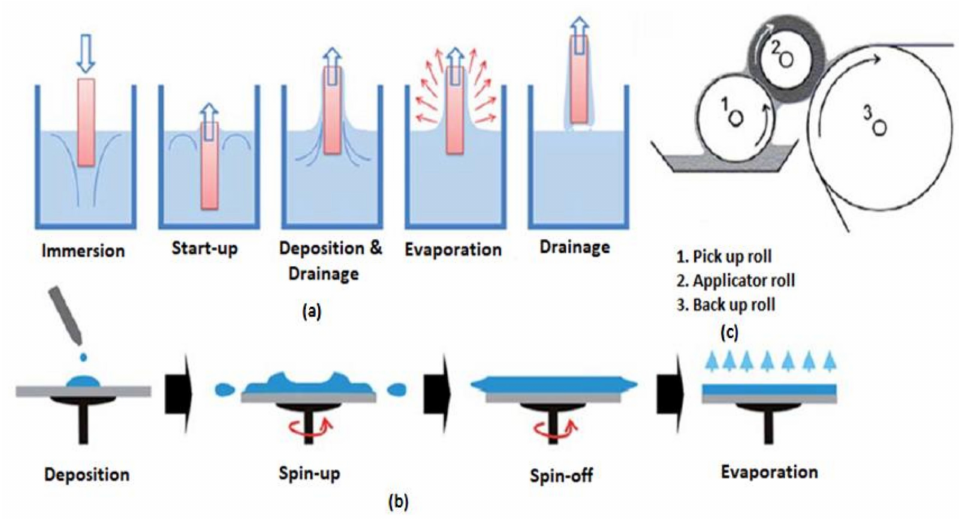
Figure 9. Steps involved in various coating techniques ( a ) Dip-coating ( b ) Spin-coating ( c ) Meniscus-coating. Reprinted with permission [39]; 2016,